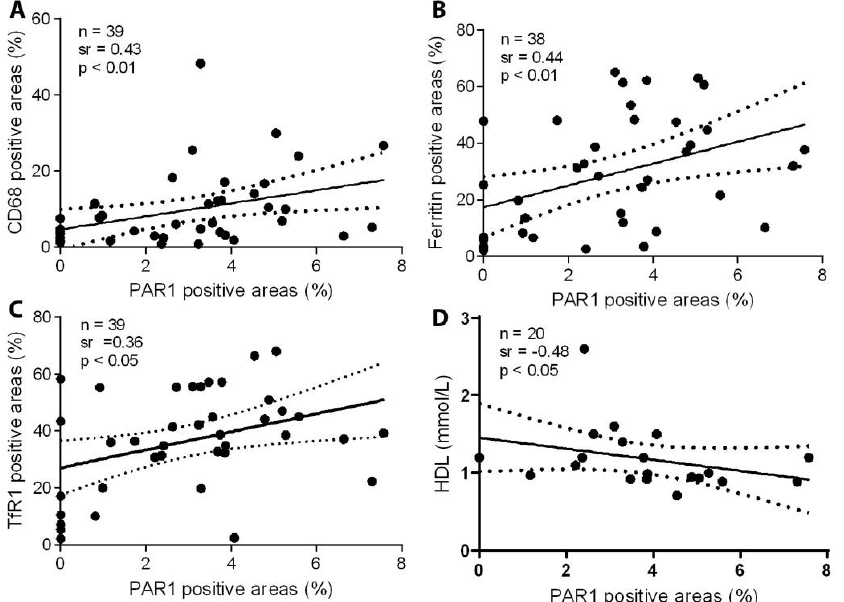
Figure 2. The expression of PAR1 in carotid atherosclerotic lesions was significantly correlated with levels of CD68-positive macrophages, ferritin, and TfR1, and inversely correlated with serum HDL. Serial sections of human carotid plaques were immunostained with antibodies against PAR1, CD68, ferritin, or TfR1, and images of the immunohistochemistry were analyzed as described in the Methods section. The expression of PAR1 was significantly correlated with CD68 ( A ), ferritin ( B ), and TfR1 ( C ), and was inversely correlated with HDL ( D ), as assessed by Spearman’s correlation coefficient test.